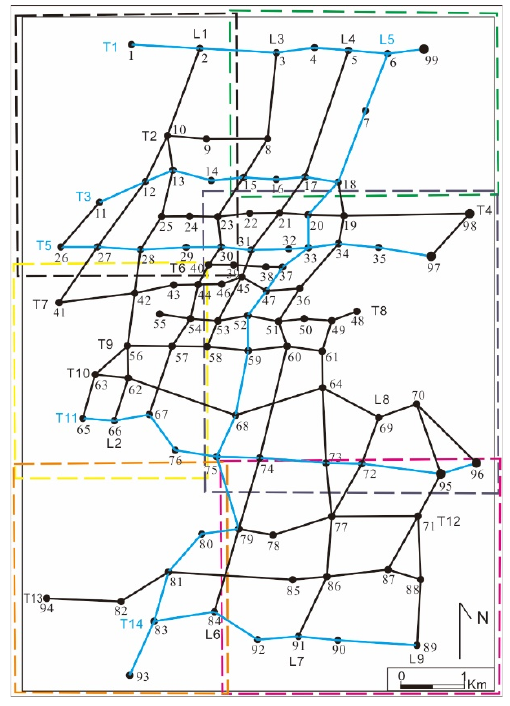
Figure 6. Location of dense drilling holes and profile in the Su-X block Sulige gas field of Ordos Basin, China; Six profiles (blue line) are described in detail. It is divided into six zones by virtual frame, the green frame is zone 1, black frame is zone 2, yellow frame is zone 3, gray frame is zone 4, red frame is zone 5 and orange frame is zone